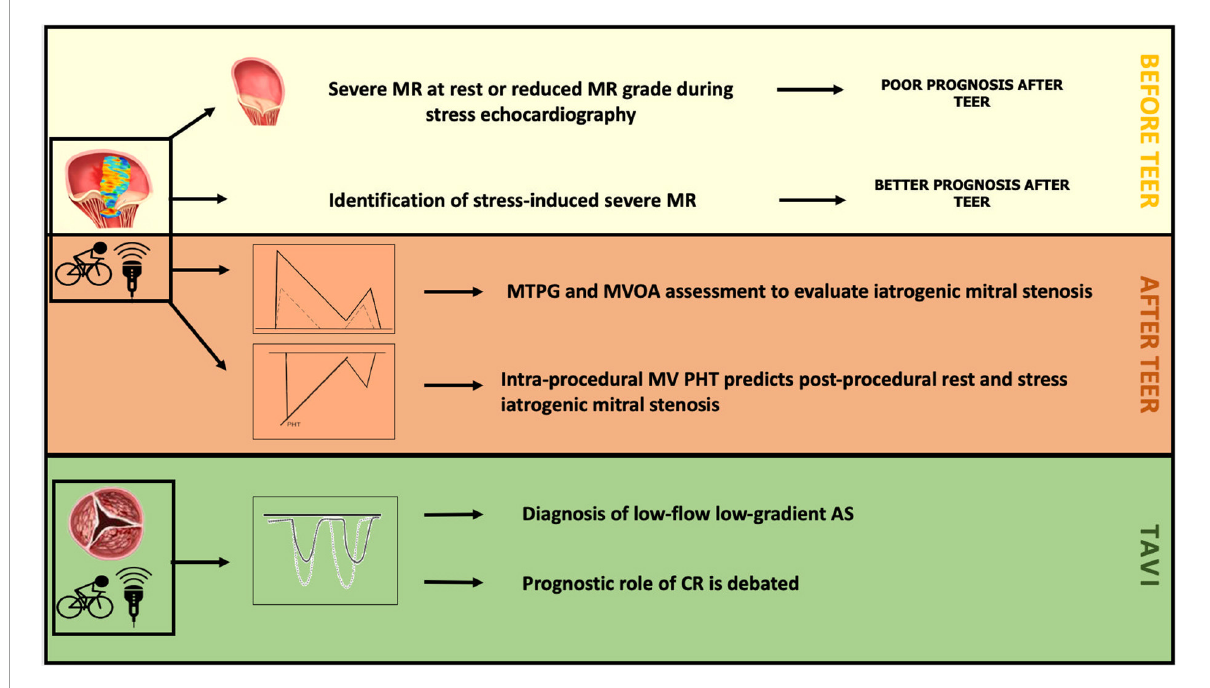
FIGURE2 Role of stress echocardiography (SE) in TEER and TAVI. MR, mitral regurgitation; TEER, transcatheter edge-to-edge repair; TAVI, transcatheter aortic valve implantation; MVOA, mitral valve opening area; MTPG, mean trans -valvular pressure gradient; MV, mitral valve; PHT, pressure half-time; AS, aortic stenosis; CR, contractile